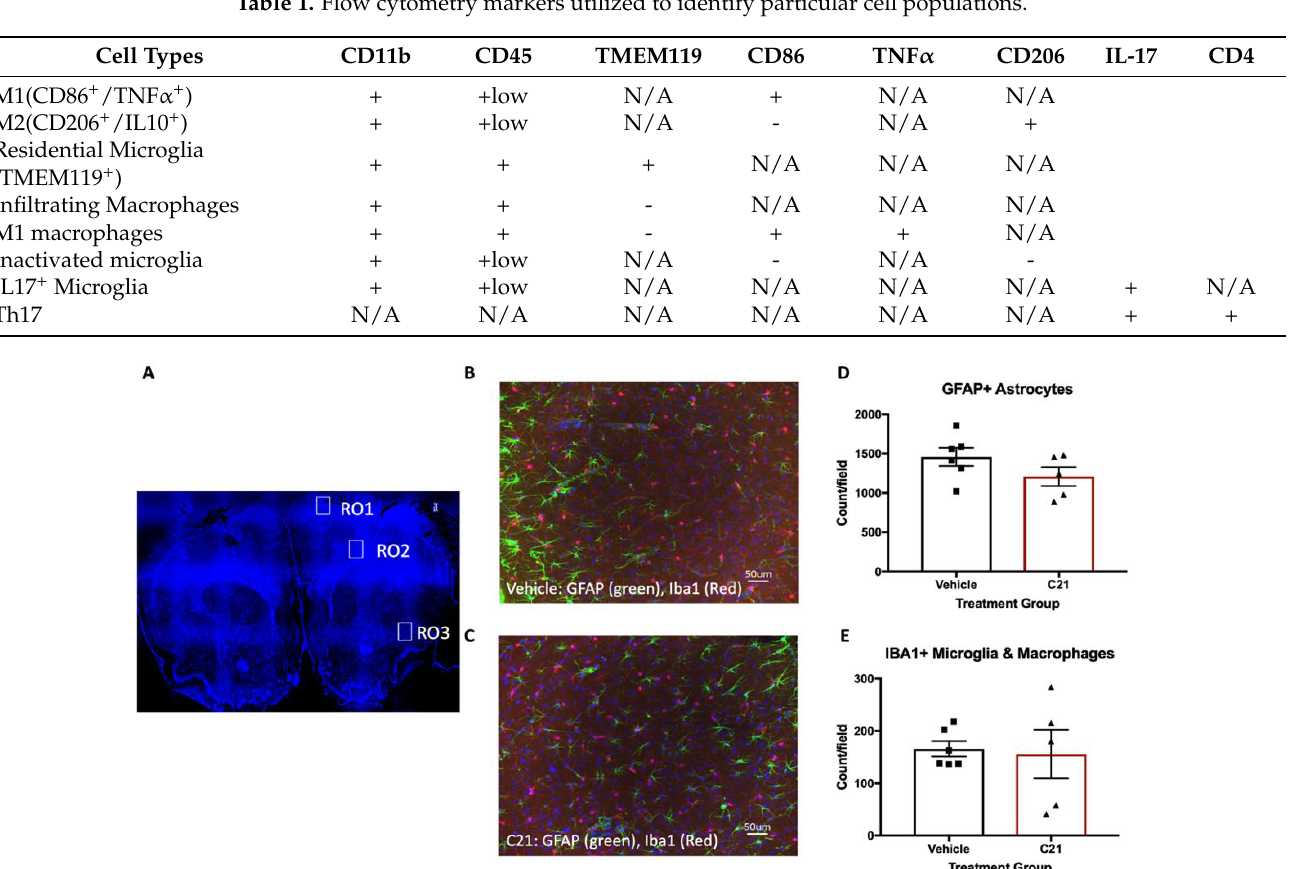
Figure 3. C21 did not affect the total number of microglia or astrocytes at the ischemic hemisphere. ( A ) Stitch illustration from a sham animal used to highlight the regions of interests (ROIs) in an intact brain section. Data are the average count of the 3 different ROIs in the ipsilateral RO1, 2 and 3 for GFAP+ and Iba1+ cells. Regions of interest ROI 1 and ROI 3 correspond to the neocortex, whereas ROI 2 corresponds to the corpus callosum and associated subcortical white matter. ( B ) Representative of stroked vehicle-treated animal taken from the cortex (ROI 1). ( C ) Representative of stroked C21-treated animal taken from the cortex (ROI 1) as well. C21 administration did not impact the number of GFAP+ ( D ) or Iba1+ ( E ) cells (n = 5–6/group). No significant differences were observed in individual ROs or the average ROIs across groups.